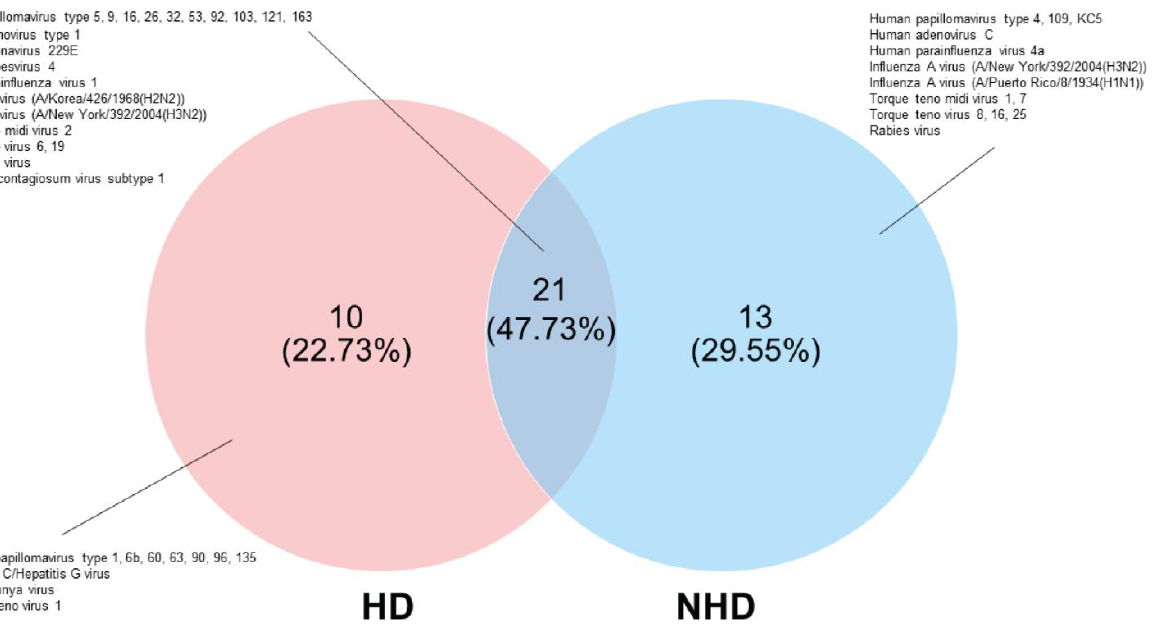
Figure 3. The unique and shared viral genera in the cervical samples. Venn diagrams showed numbers of unique and shared OTU (species) of human viruses between the HD and NHD groups.